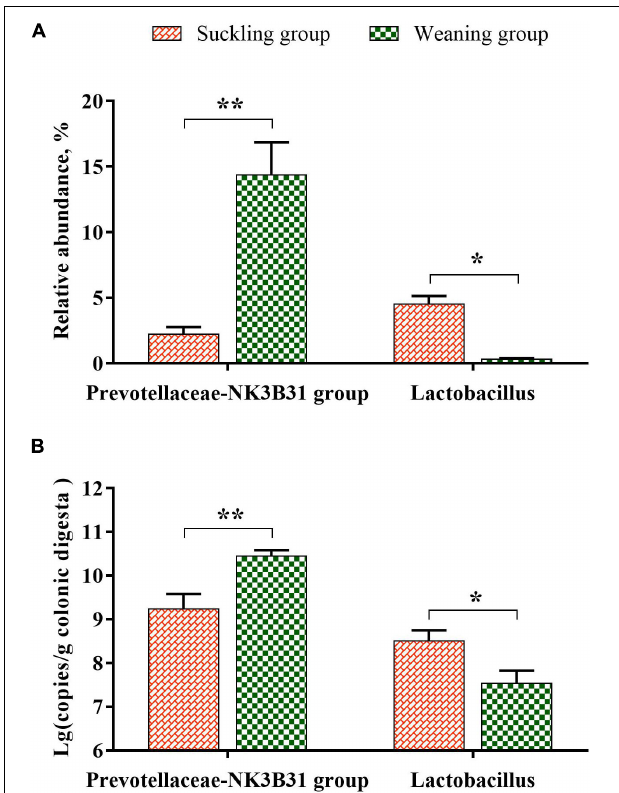
FIGURE 4 | The column chart identifying the significantly different taxa between the suckling group and the weaning group at the genus level. (A) The results of pyrosequencing; (B) the verification results of qPCR (log 16S rRNA gene copy number/g fresh matter). Graph shows means value ± SEM ( N = 7), * significant difference ( P < 0.05) and ** significant difference ( P < 0.01) between the suckling group (orange column) and the weaning group (green column).